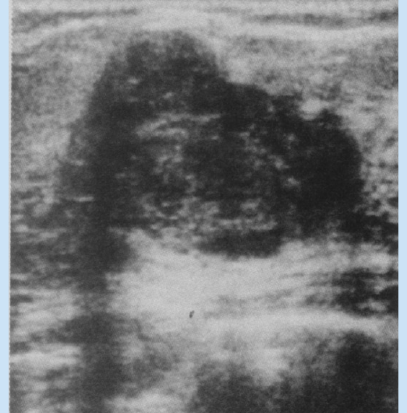
Fig. 1a. Transverse section of fibroadenoma on ultrasound.